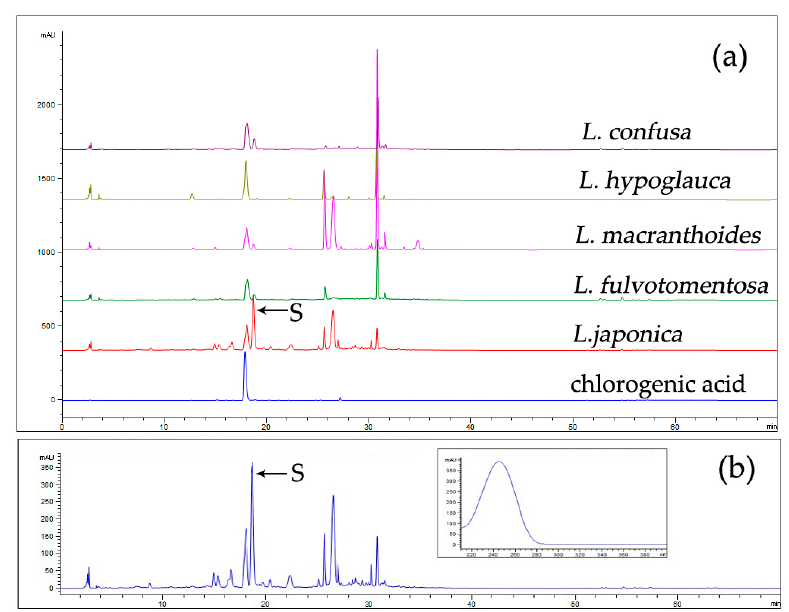
Figure 2. The overlapping fingerprints of L. japonicae flos (LJF) and LF ( a ) and the UV spectrum of compound S in LJF ( b ). Column: An Agilent ZORBAX XDB C18 (4.6 × 250 mm, 5 µ m) column; column temperature, 30 ◦ C; mobile phases: phosphoric acid solution (A) and acetonitrile (B) (5–15% B at